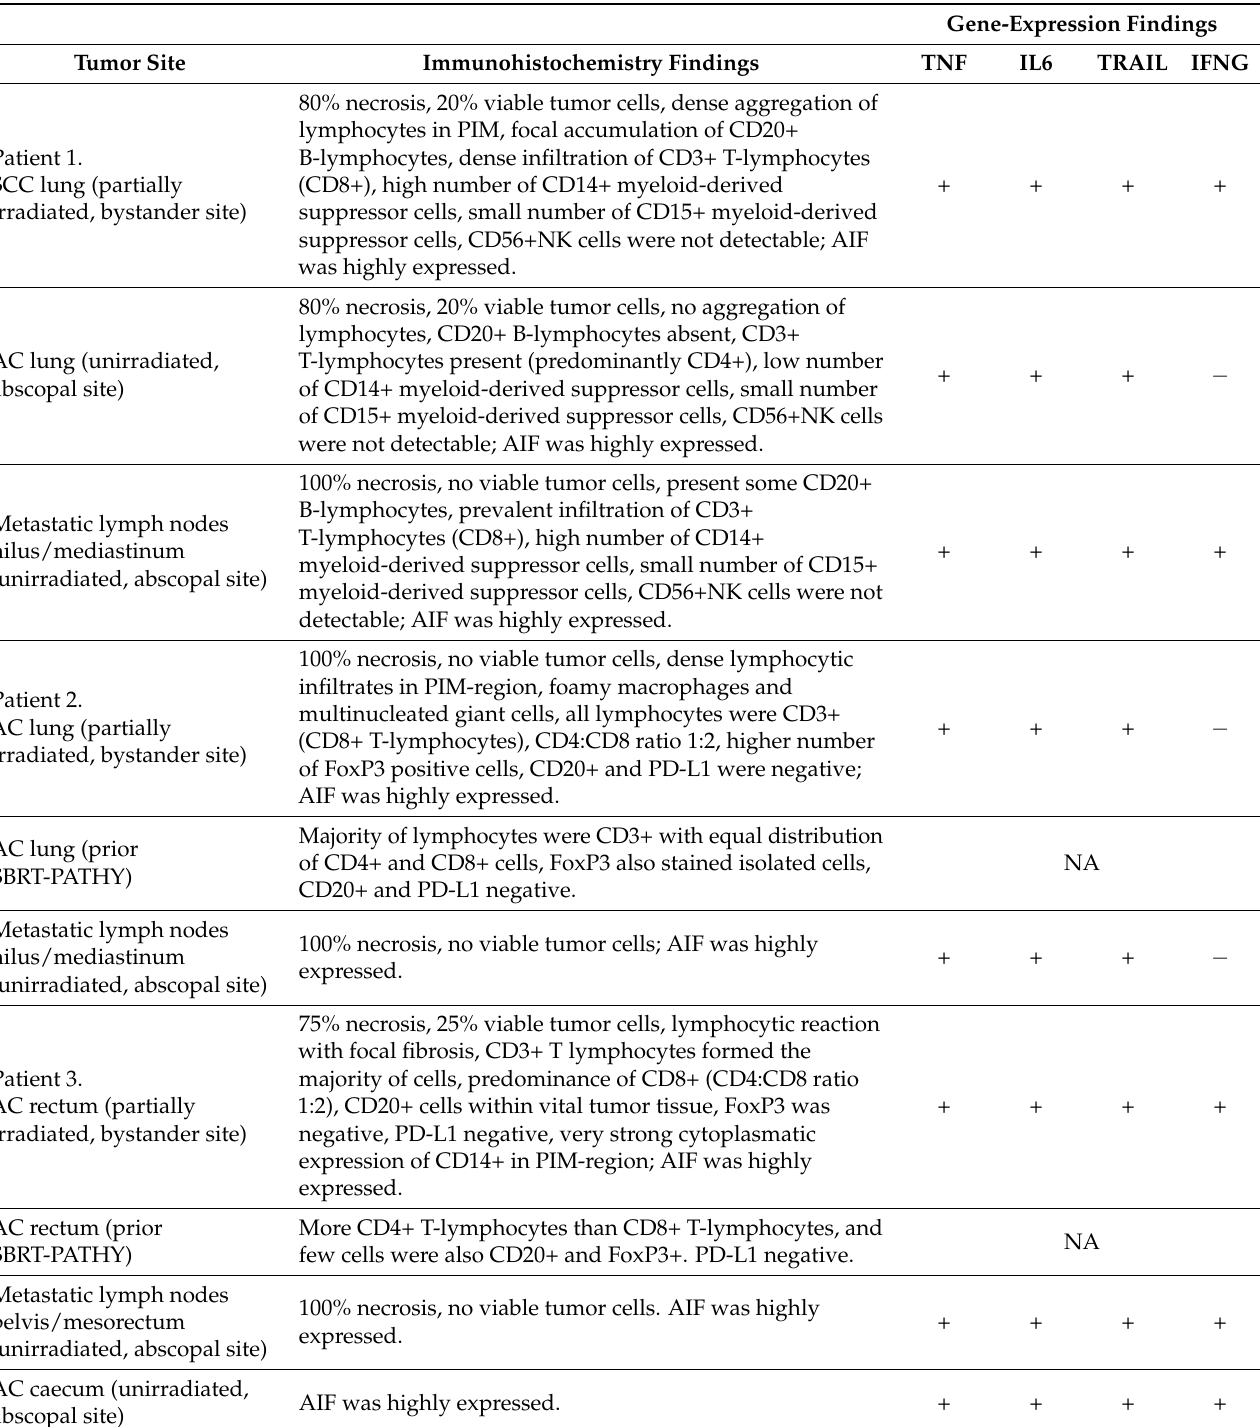
Gene-Expression Findings